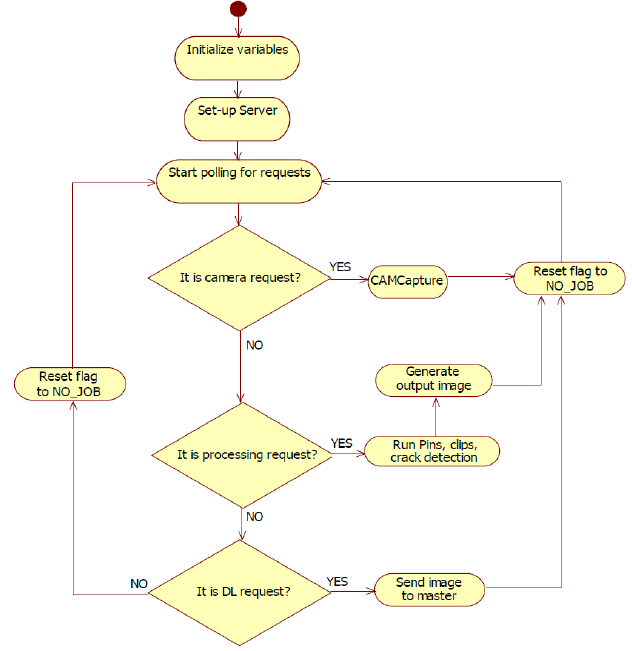
Figure 9. Slave node diagram of activities.